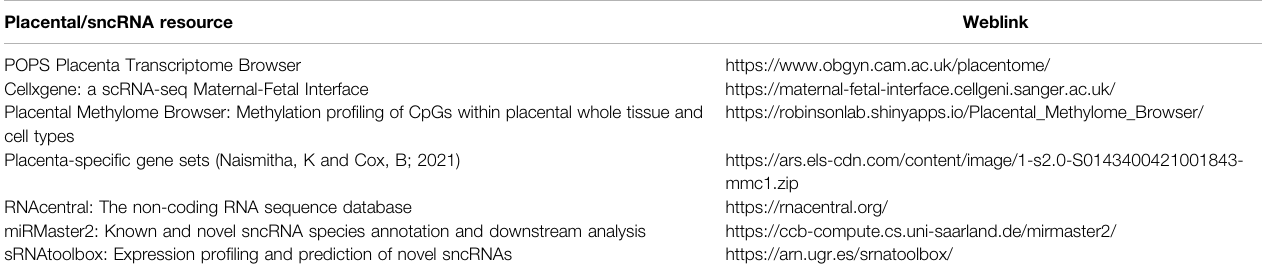
TABLE 1 | Online placental and sncRNA resources. Placental databases displaying condition-speci fi c mRNA, sncRNA, single-cell RNA expression. Small non-coding RNA databases include detailed species information, and online tools dedicated to species annotation and expression pro fi ling, exploratory data analysis, correlation and differential expression